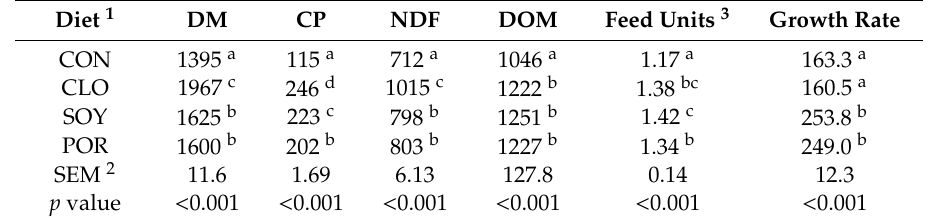
Table 7. Average DM, CP, NDF, DOM (g / d) and feed unit (FU) intake and growth rate (g / d) of lambs fed the experimental diets in in vivo Experiment 2.